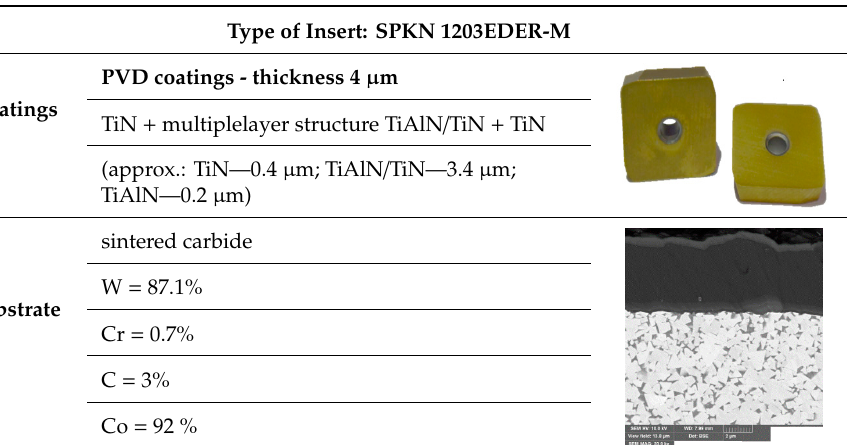
Table 3. Coating and substrate of used cutting inserts.